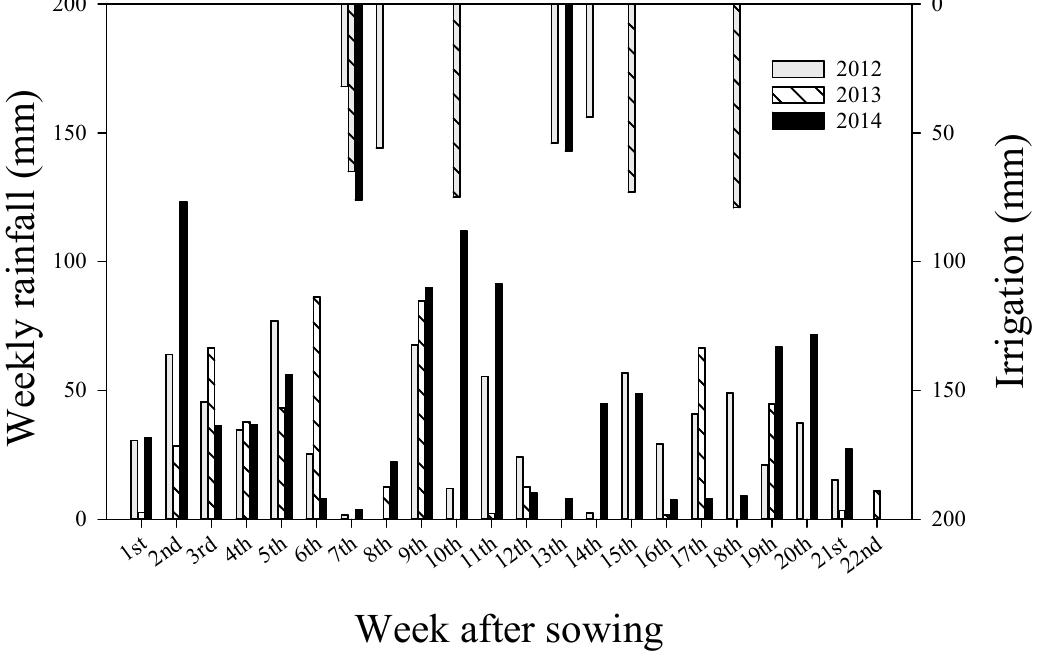
Figure 1. Precipitation (bottom) and irrigation (top) distribution during the rice growing season in all three years, from 2012 to 2014.